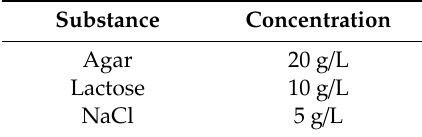
Table 4. Composition of deficient agar.